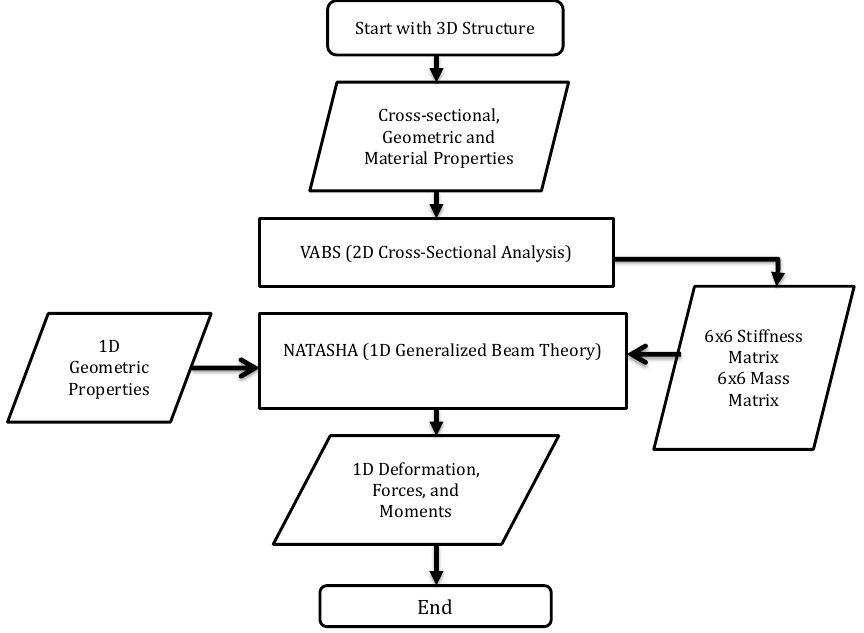
Figure 4. The high-fidelity structure model, coupling VABS [28] and NATASHA [26], for aeroelastic analysis of high-aspect ratio